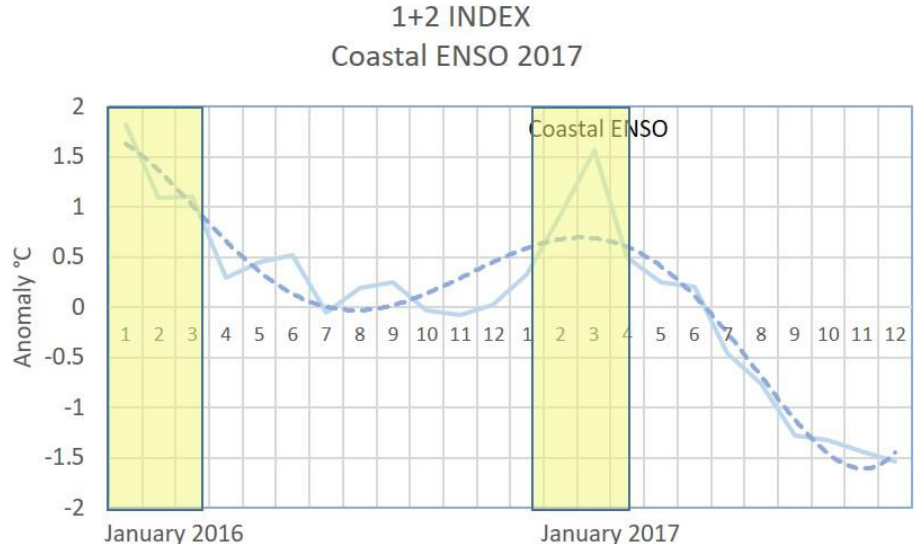
Figure 6. Time series of the year 2016 and 2017 using the 1 + 2 index. An increase in SST is observed in both years and in 2017 (March). Therefore, it does not contribute appropriately to establish the present of coastal